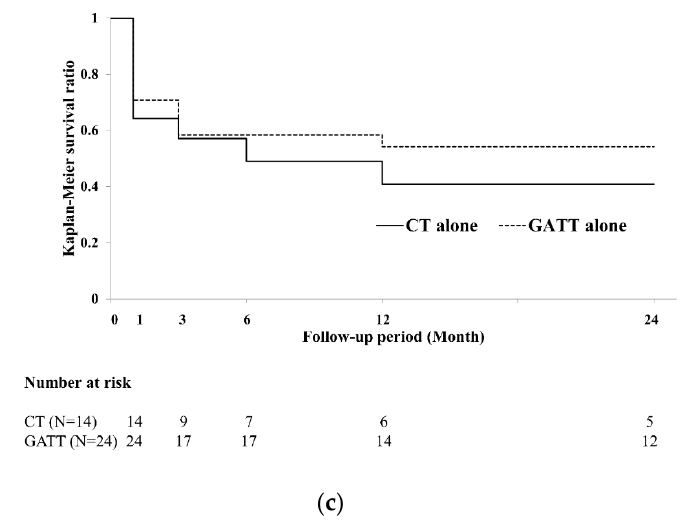
Figure 1. Kaplan–Meier survival curves of surgical success in the CT (solid line) and GATT (dotted line) groups. ( a ) Survival curve of all eyes in the CT and GATT group. Differences between the two groups were significant using the log-rank test ( p < 0.005). ( b ) Survival curve in eyes that underwent CT or GATT with phacoemulsification. Differences between the two groups were statistically significant using the log-rank test ( p < 0.001). ( c ) Survival curve in eyes that underwent CT or GATT without phacoemulsification. Differences between the two groups were not statistically significant using the log-rank test ( p = 0.55). CT, conventional trabeculotomy; GATT, gonioscopy-assisted transluminal trabeculotomy.